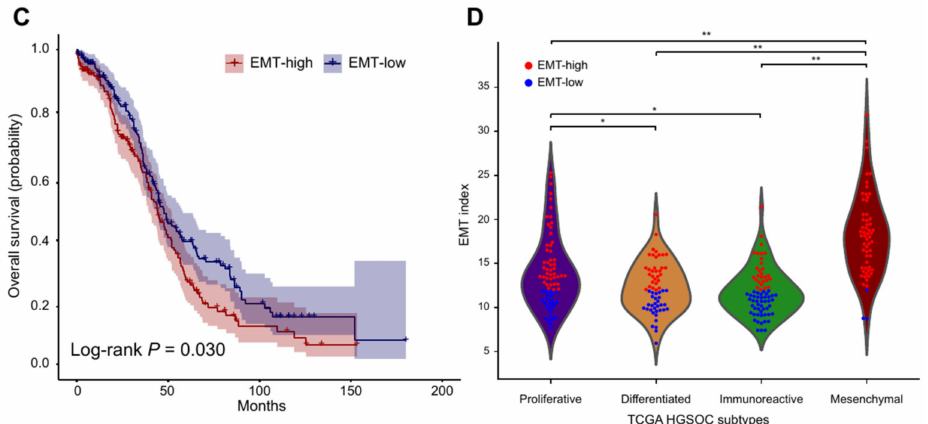
Figure 5. Application of the EMT index to TCGA HGSOC data. ( A ) Distribution of EMT index of TCGA HGSOC displayed on a box plot. ( B ) Scatter plots illustrating relationship between the EMT index and EMT-related gene expression in the cohort. Each dot represents each sample analyzed, and red lines are a linear trend representation of the scatter plots. ( C ) Kaplan–Meier plot depicting overall survival of TCGA HGSOC samples falling into EMT-high (red) and -low (blue) groups. ( D ) EMT index for four TCGA subtypes was compared and the mesenchymal subtype exhibited the highest EMT index (one-way ANOVA test p < 0.001; Tukey’s HSD adjusted p < 0.005 ** and < 0.05 *). Red dots and blue dots inside the violin plots represent EMT-high and -low samples,